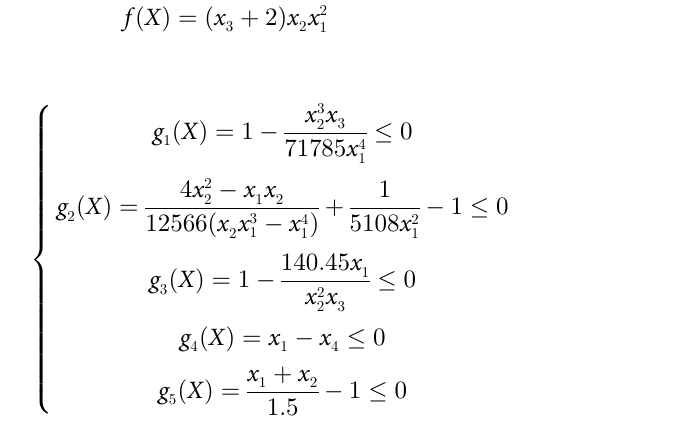
the current locally trap at 250 iterations, the solution obtained by GOA is still not as good as TAVOA. 4.4.2 The compression/tension spring design problem. As shown in Fig 16, the main goal to be solved in the compression/tension spring design problem is how to select the effec- tive number of active coils ( n ), wire diameter ( d ) and mean coil diameter ( D ) of the spring to minimize the mass of the spring [57]. According to the limitations of physical laws, the compression/tension spring design prob- lem is constrained by shear stress, surge frequency and minimum deflection. If the variables to be optimized are considered as X = [ x , x , x ] = [ d , D , N ], the problem is described as Eq (29), 1 2 3 and its constraints are defined as Eq (30).